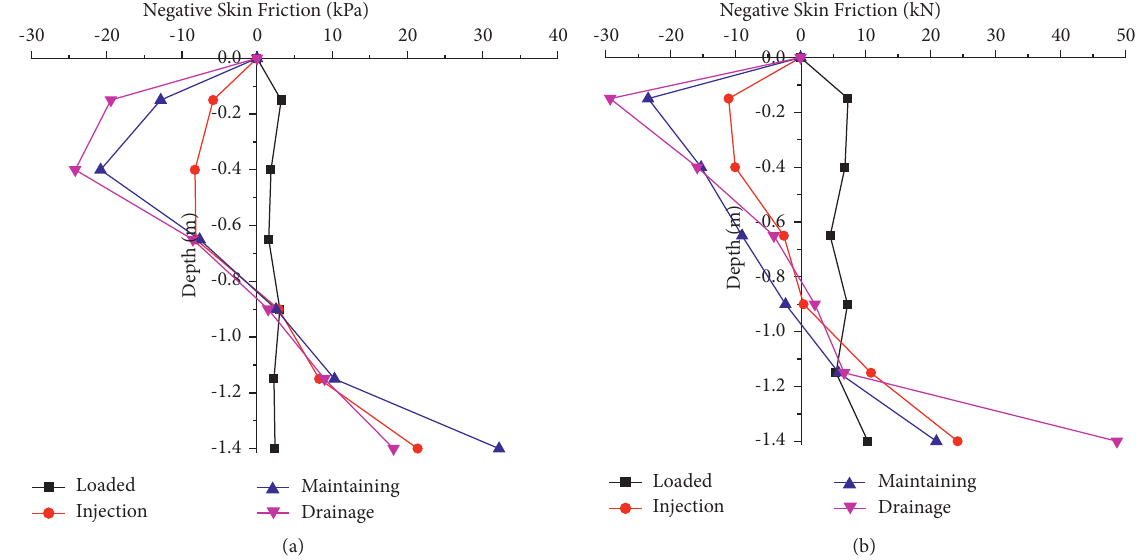
Figure 7: Average negative skin force distribution of piles in different test conditions. (a) Pile load: 12kN. (b) Pile load: